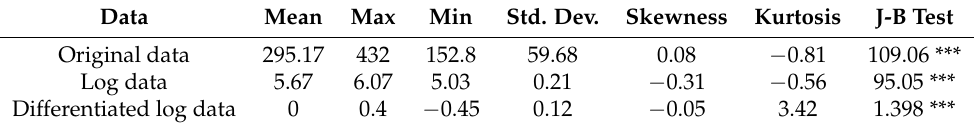
Figure 5. The standard FPCA of the container throughput of Shanghai Port. Table 1. The descriptive statistic results of container throughput in Shanghai